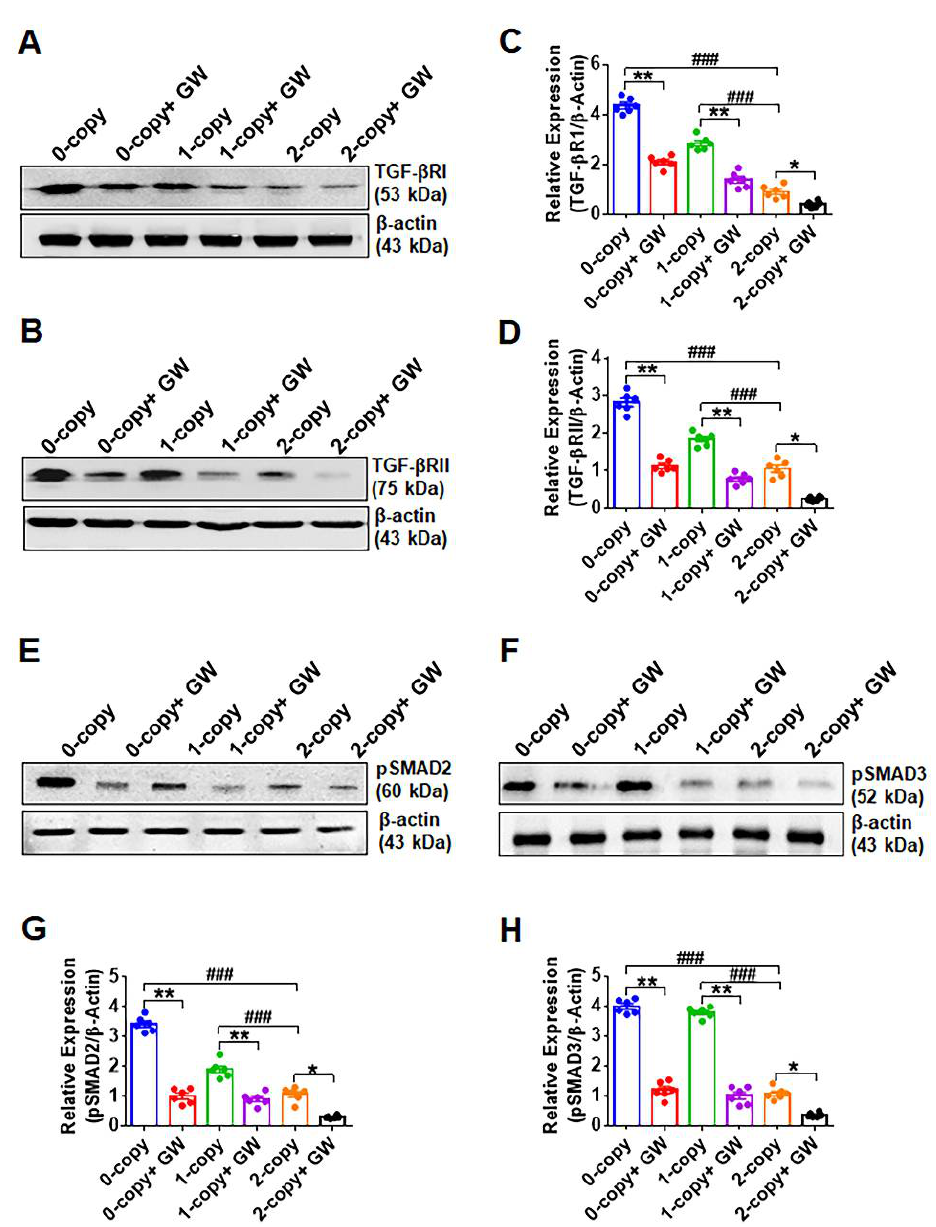
Figure 4. Western blot analysis of TGF- β 1 receptors and SMAD proteins in the heart tissues of control and drug-treated male Npr1 gene-ablated mice: representative Western blots showing the protein expression of TGF- β 1RI and TGF- β 1RII (panels ( A , B )). The densitometry analysis of proteins was normalized to β -actin expression (panels ( C , D )). Representative Western blots showing the protein levels of pSMAD-2 and pSMAD-3 (panels ( E , F )). Densitometry analysis of pSMAD-2 and pSMAD-3 proteins was normalized to β -actin (panels ( G , H )). Values are expressed as means ± S.E. (n = 6 animals in each group). Statistical significance is expressed as ### p < 0.001, vehicle-treated 0-copy and 1-copy vs. 2-copy; * p < 0.05, ** p < 0.01, vehicle-treated 0-copy,1-copy and 2 copy vs. drug-treated same gene copy